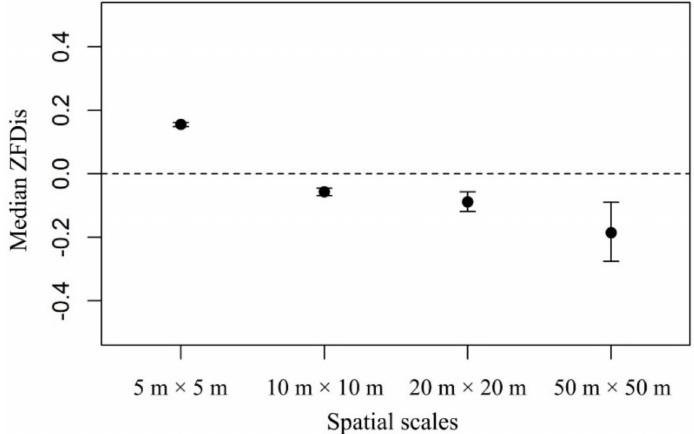
Figure 5. The trait dispersion (FDis) of a multivariate trait (AT) for all trees across four spatial scales. Positive median ZFDis indicates community assembly is dominated by biotic interactions. Negative median ZFDis indicates community assembly is dominated by environmental filtering. Error bars are 95% confidence intervals, calculated by the Wilcoxon